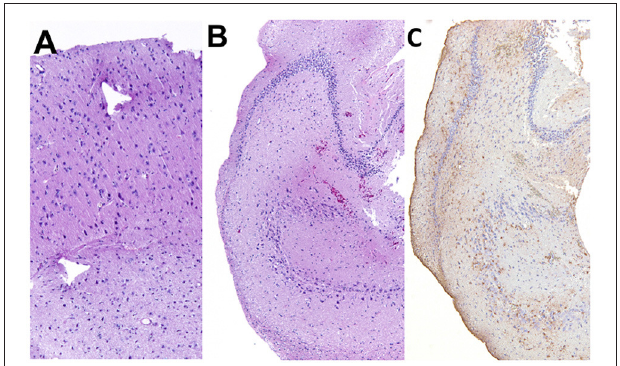
FIGURE 11 | Histopathology of the resected cortex (A) and hippocampus (B,C) . Shrunken neurons with pyknosis were generally observed in both specimens. In the hippocampus, mild gliosis was observed. (A,B) Hematoxylin and eosin staining. (C) Anti-glial fibrillary acidic protein